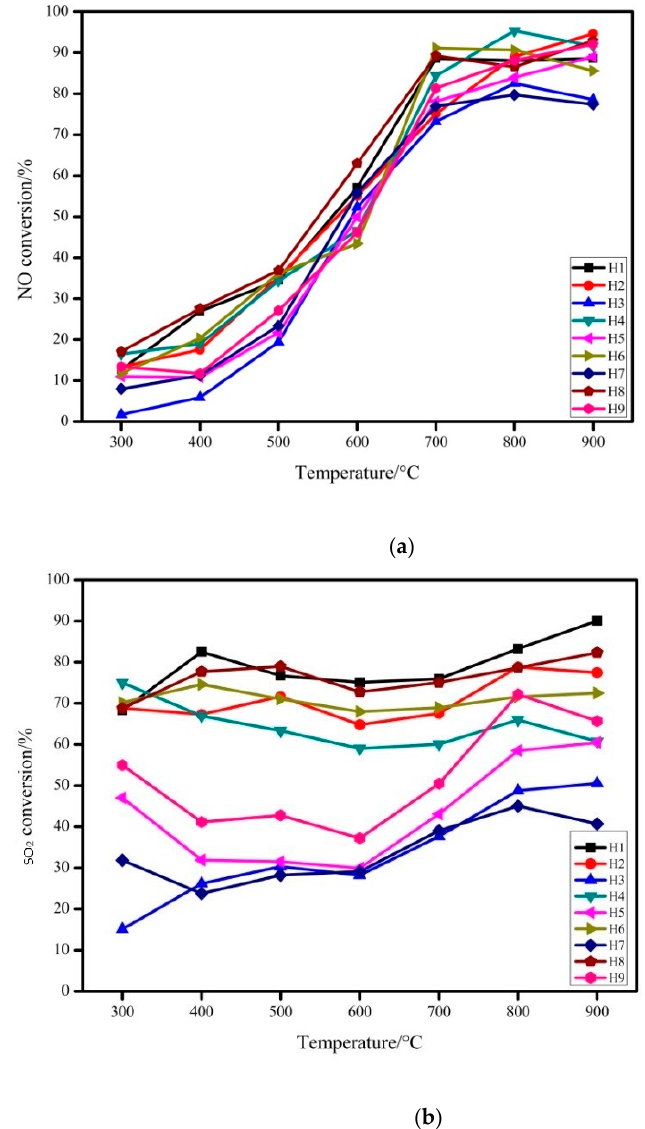
Figure 3. Desulfurization and denitrification performances of modified absorbents in the full tem- perature range (300–900 °C) : ( a ) NO conversion as a function of the temperature (300–900 °C) of the modified absorbents and ( b ) SO 2 conversion as a function of the temperature (300–900 °C) of the modified absorbents.